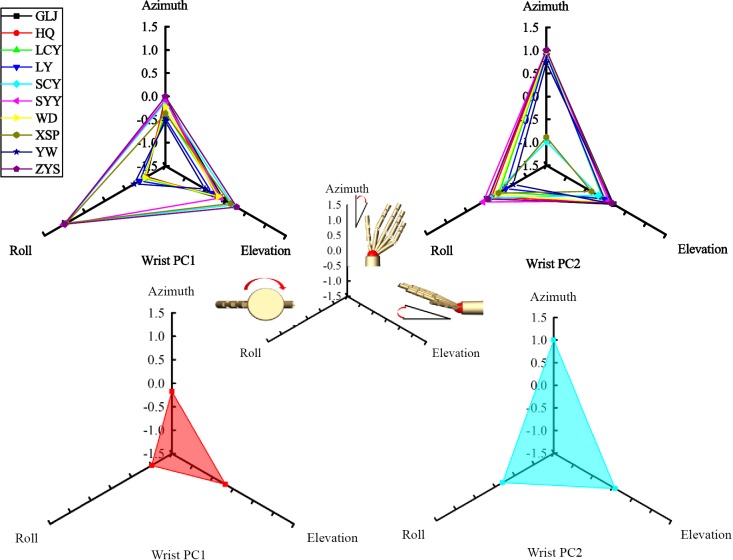
First two PCs of wrist postures to each subject and all ten subjects.The abbreviations represent the name of each subject.